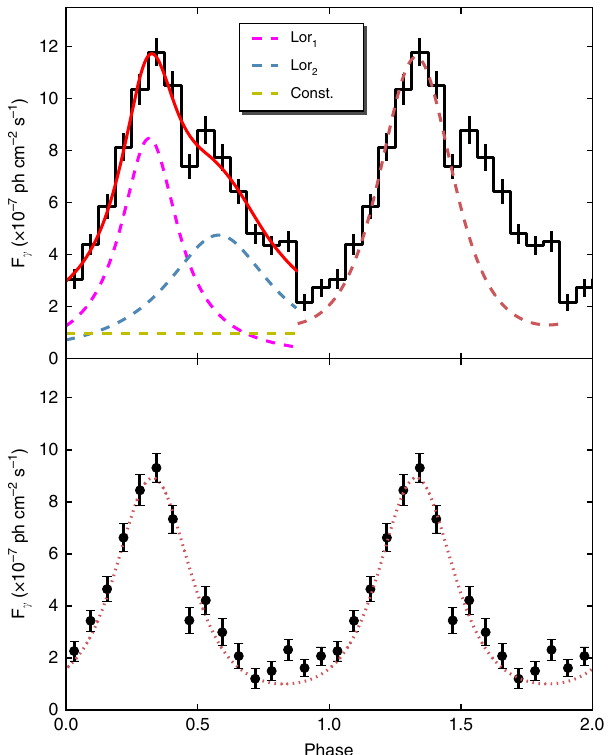
Fig. 3 Modulation properties of the quasi-periodic oscillation. In the top panel, the folded light curve, which is constructed from binned likelihood analysis of the six cycles of Fermi data shown in Fig. 1, is plotted as a black histogram, and the error bars are 1 σ uncertainties. Phase zero corresponds to MJD 57692.66 and 16 phase ranges are set. Two cycles are shown for clarity. The red solid curve is a fi t to the light curve, which consists of two Lorentz functions (magenta and blue dashed curves) plus a constant (yellow dashed line). The dark-red dashed curve is the modulation curve produced from the simple helical jet model, but it does not fi t the right wing of the observed data points. In the bottom panel, we show the main modulation data points when the weak Lorentz function is subtracted. The helical jet model (red dotted curve) can provide a fi t to the modulation